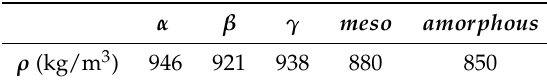
Table 1. List of densities used in Equation